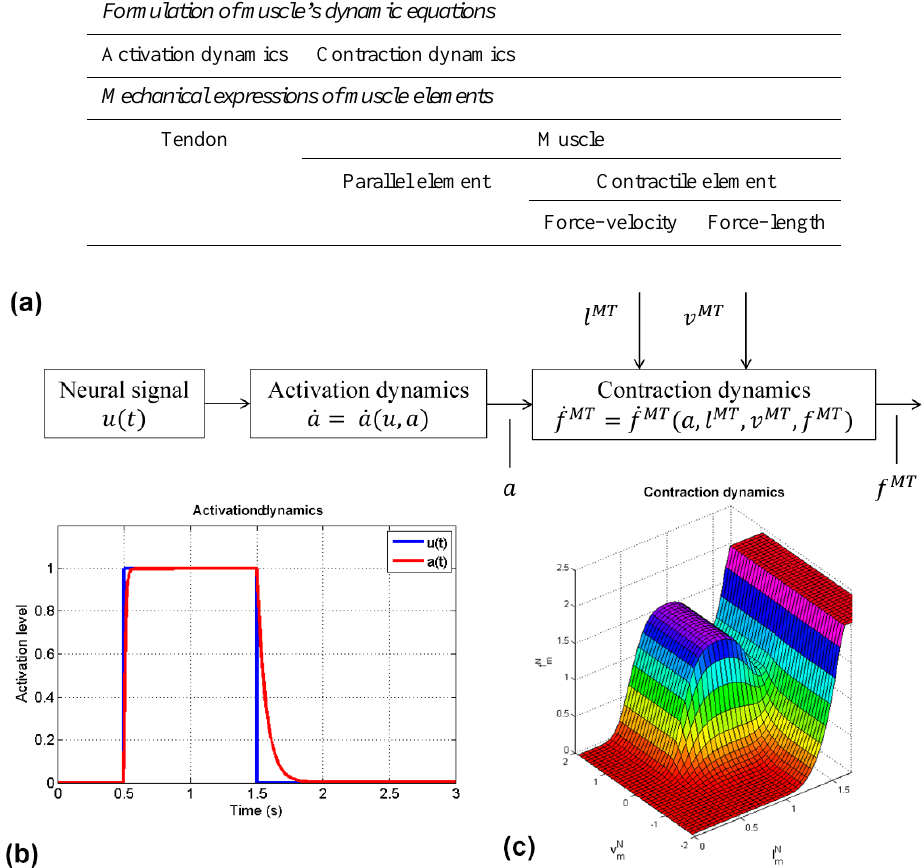
Figure 2. (a) Schematic representation of muscle dynamics: inputs and outputs for activation and contraction dynamics. (b) Activation dynamics. (c) Contraction dynamics including the effects of the parallel elastic